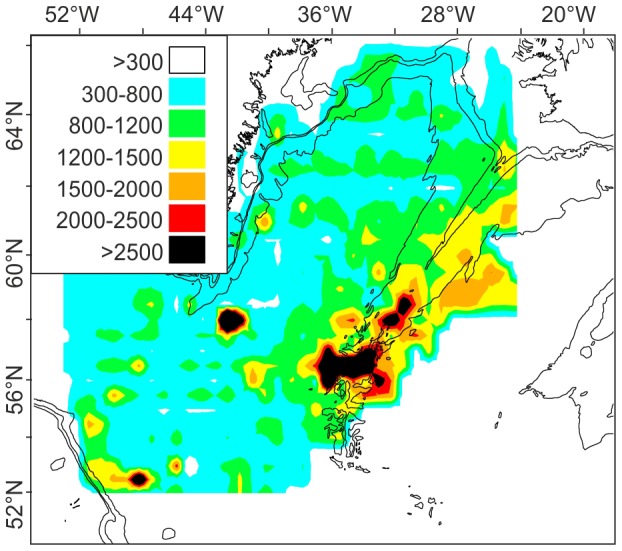
Spatial distribution of area backscatter.Area backscattering coefficient (m2 nautical mile−2), from the mesopelagic deep scattering layer. Recordings from multi-ship surveys using calibrated SIMRAD 38 kHz echosounders integrating down to 750 m depth (1000 m after 1999). Composite image of data from 1996–2009 during June–July.